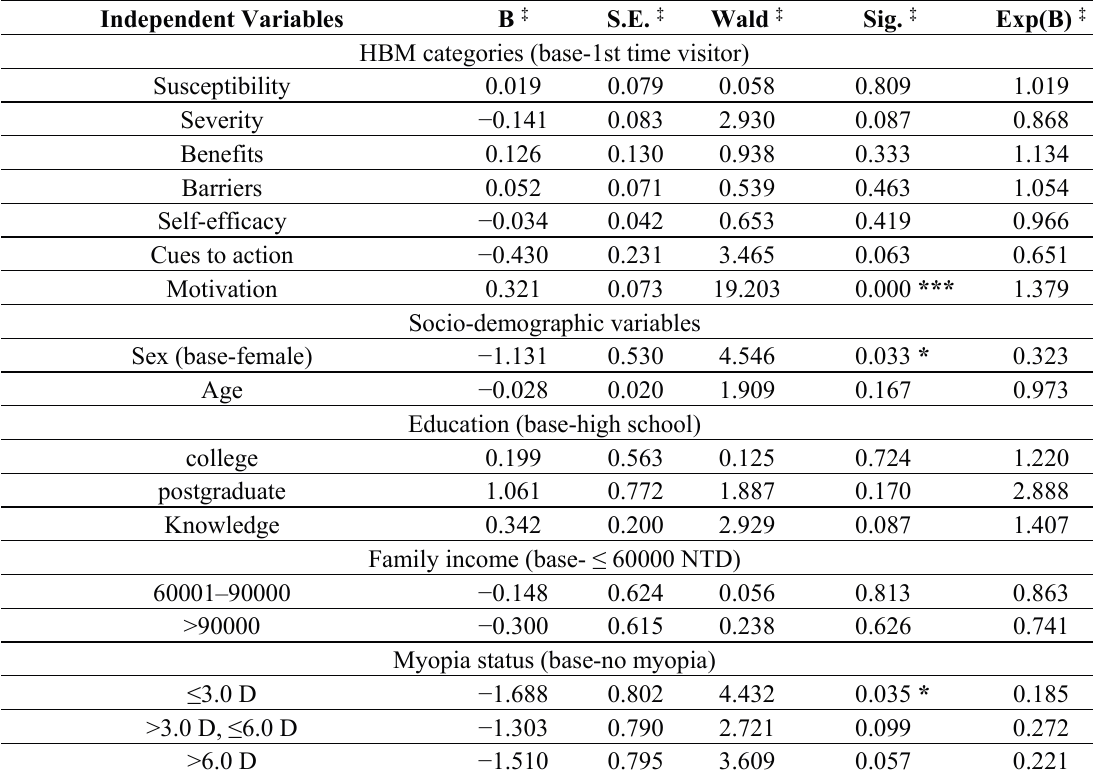
Table 2. Results of the logistic regression